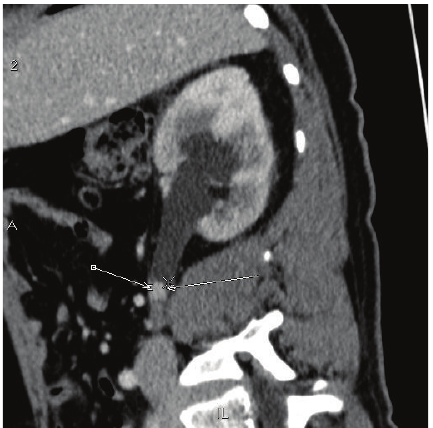
Figure 4: Axial arterial phase staging CT scan again demonstrating a 96mm left renal mass.